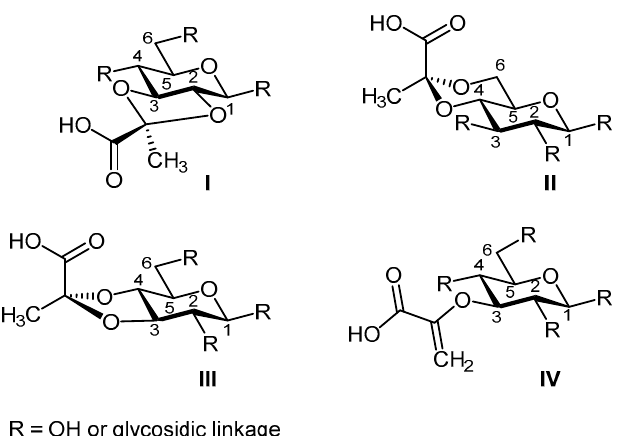
Figure 1. Overview on the most common modes of monosaccharide pyruvylation. Shown is pyruvate ketal at bridging positions 2,3 ( I ), 4,6 ( II ), and 3,4 ( III ), and enol pyruvate ( IV ). Arabic numbers indicate ring positions.